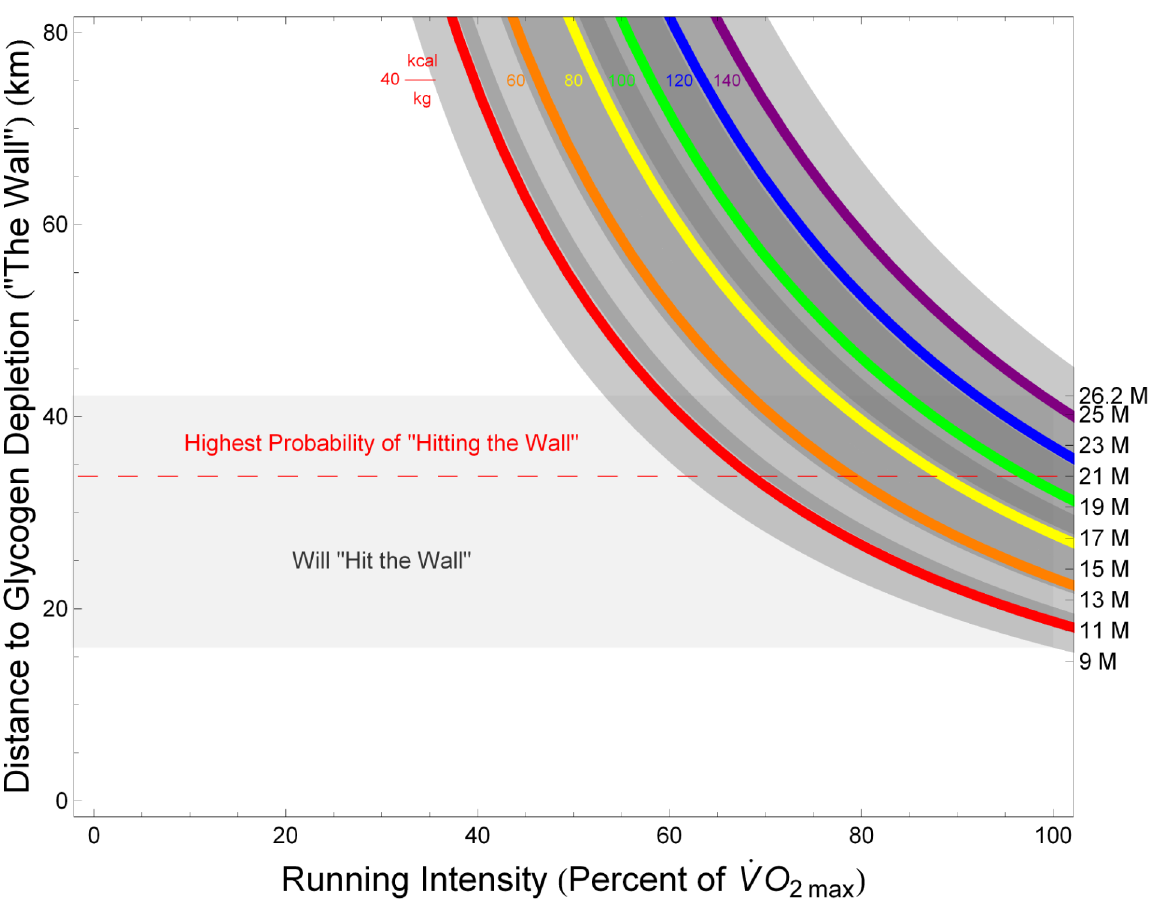
Figure 3. Distanceto ‘The Wall’ forendurancerunners. Computed distanceathletes can run before completely depleting glycogen reserves (‘hitting the wall’), as a function of running intensity (expressed as a percent of _ VVO 2 max ), relative leg muscle mass (leg muscle mass as a fraction of total body mass), and muscle glycogen density. The distance an athlete can run before ‘hitting the wall’ decreases with increasing levels of exertion, and as the shaded rectangular region labeled ‘Will ‘‘Hit the Wall’’’ indicates, if this distance is less than 42.195 kilometers (26 miles and 385 yards) then the runner will not be able to complete a marathon without experiencing complete glycogen depletion (at least not without refueling midrace). Each colored curve corresponds to a particular density of muscle glycogen, as labeled (Red, 40; Orange, 60; Yellow, 80; Green, 100; Blue, 120; Purple, 140kcalkg { 1 leg muscle ). The colored curves each correspond to athletes whose leg muscles constitute 21.4% of total body mass and are loaded with glycogen at a particular density (relative liver mass has been assumed constant at 2.5% of total body mass, and liver glycogen density has been assumed maximized at 360kcalkg { 1 liver mass ); a shaded region around each colored curve fills the region corresponding to relative leg muscle masses of 15% to 25% total body mass. Darker shading indicates overlapping regions and identical failure distances for different sets of physical parameters: The area of densest shading straddles the 21-mile line for athletes running at intensities of 80% to 95% _ VVO 2 max , indicating that many different athletic builds and levels of glycogen loading are subject to failure at these intensities around mile 21, which has been empirically identified as the distance at which marathon runners most commonly ‘hit the wall.’ By contrast, few runners will ‘hit the wall’ before mile 11, or when running a marathon at less than 55% _ VVO 2 max .